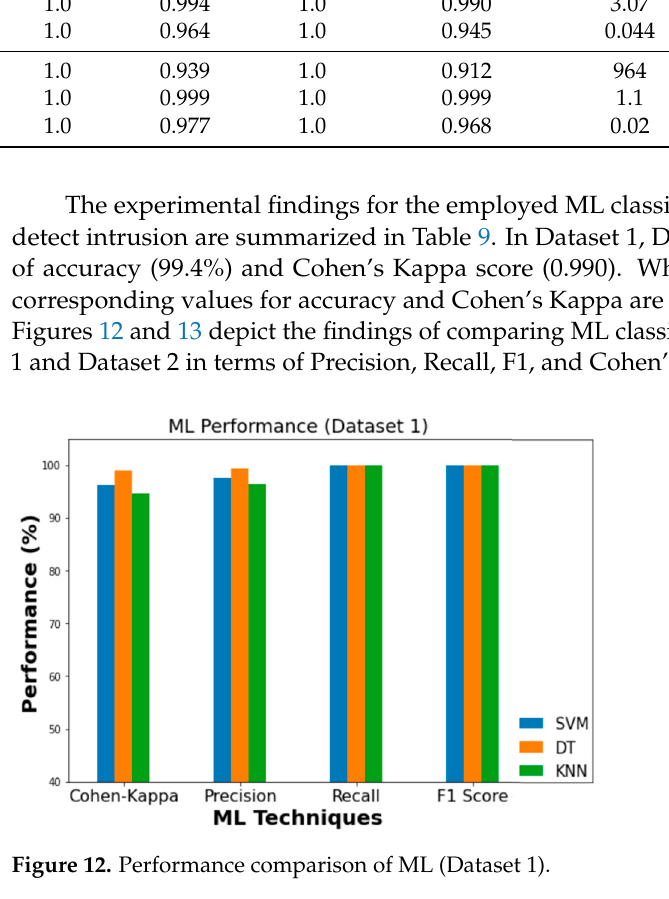
Figure 13. Performance comparison of ML (Dataset 2).